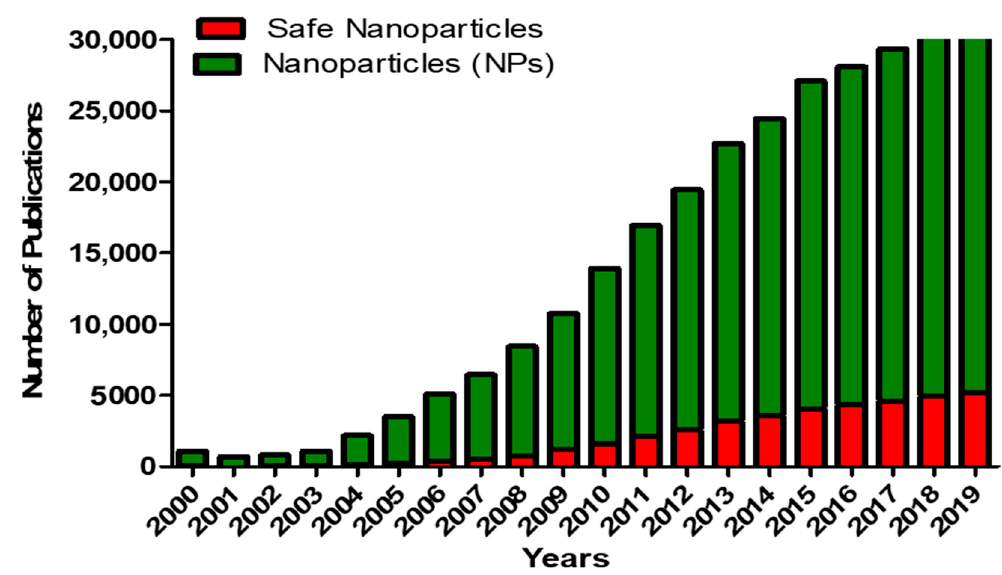
Figure 1. The number of scientific papers published in the last two decades. Papers were identified in Pubmed database from the year 2000 until 2019 using the key words nanoparticles (green) and safe nanoparticles, toxicity of NPs (nanoparticles), risks of NPs (red).